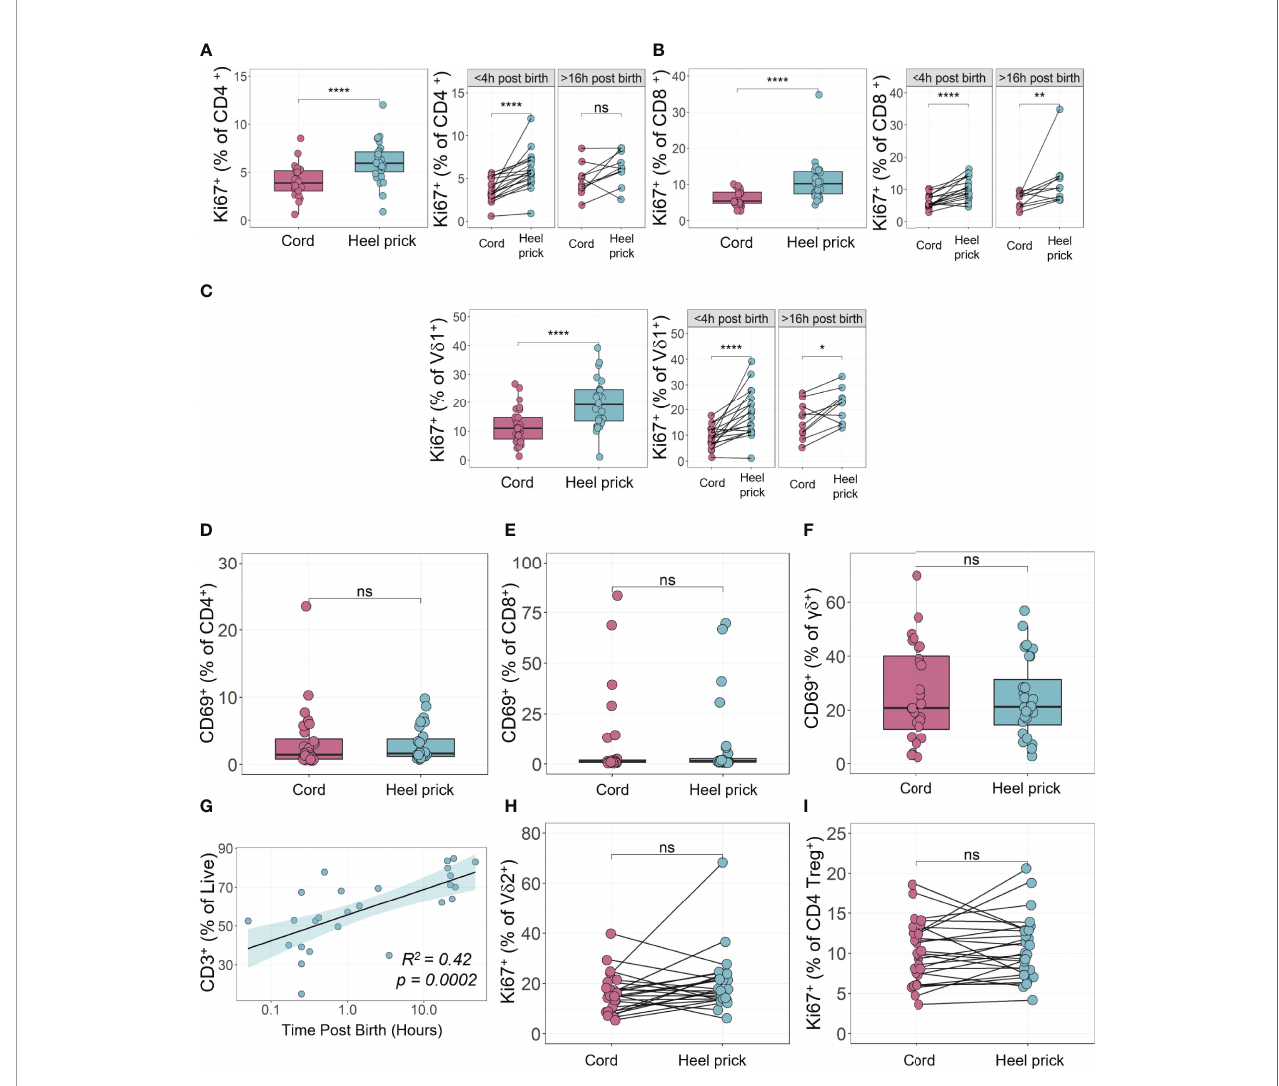
FIGURE 2 | Enhanced proliferation in neonatal T cells observed immediately post birth (A – C) The percentage of proliferating (Ki67 + ) CD4 + (A) , CD8 + (B) , and V d 1 + gd (C) T cells from unstimulated paired cord blood (n=28) stained immediately post thawing compared to heel prick samples collected <4 h (n=18) or >16 h post birth (n=10) (D – F) The percentage of activated (CD69 + ) CD4 + (D) , CD8 + (E) and gd + (F) T cells from unstimulated paired cord blood and heel prick samples (n=28) stained immediately post thawing. (G) Time dependent linear regression analysis of the percentage of live CD3 + T cells from unstimulated heel prick blood samples collected within 48 h post birth (n=28). (H, I) The percentage of proliferating (Ki67 + ) V d 2 + gd (H) , and CD4 + Treg (I) cells from unstimulated paired cord blood and heel prick samples (n=28) stained immediately post thawing. Box and whisker plots follow standard Tukey representations and indicate the median (central line), the interquartile range (upper line = 75 th percentile, lower line = 25 th percentile), and the whiskers represent 1.5 x 75 th /25 th percentile. P values (NS, non-signi fi cant; ****p<0.0001) for all paired data between cord and heel prick samples were assessed using two-sided paired Wilcoxon tests. *p<0.05,